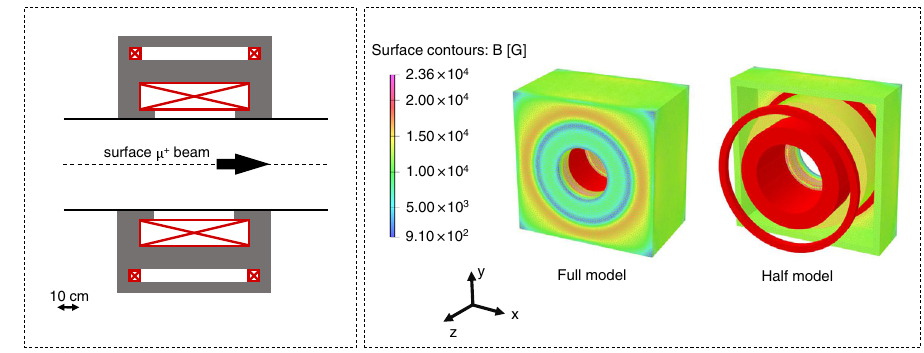
FIG. 16. Model 3: the iron housing solenoid with compensation coils.